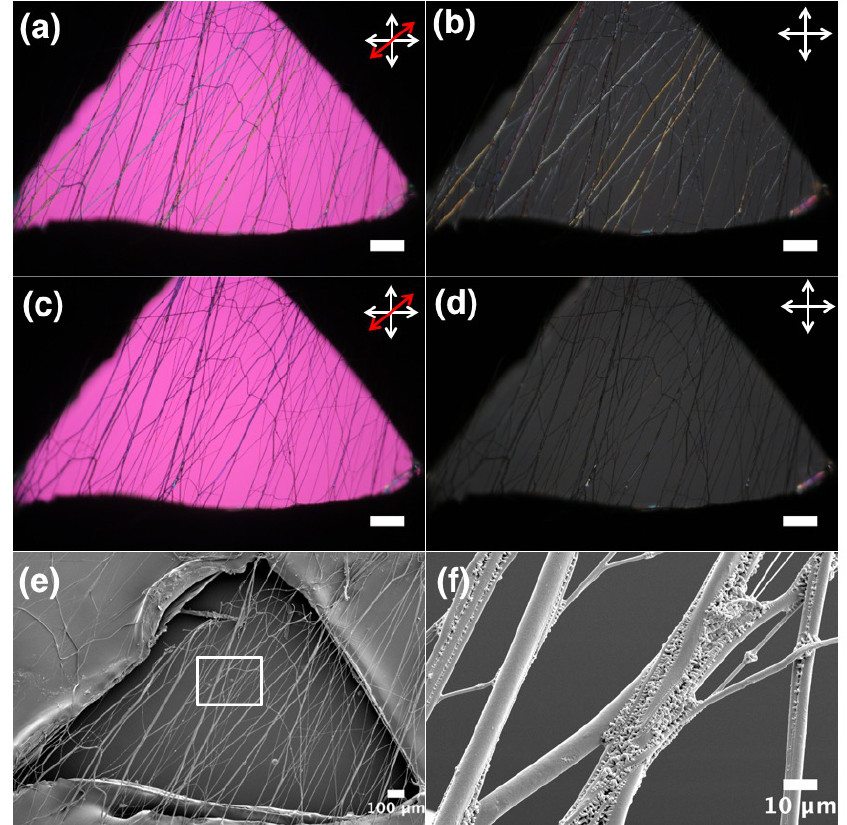
Figure 8. POM image between crossed polarizers: ( a , b ) PLA + LCE fibers at 20 ◦ C; ( c , d ) PLA + LCE fibers: at isotropic phase at 70 ◦ C; and ( e , f ) SEM image of same sample heated to 75 ◦ C above phase transition of LCE. Images a and c are with red wave plate between crossed polarizers (scale: 200 µ m). The white double-ended arrows depict the orientation of polarizer and analyzer, respectively, and the red double-headed arrow in ( a , c ) shows the direction of optic axis of a first-order λ plate inserted in the light